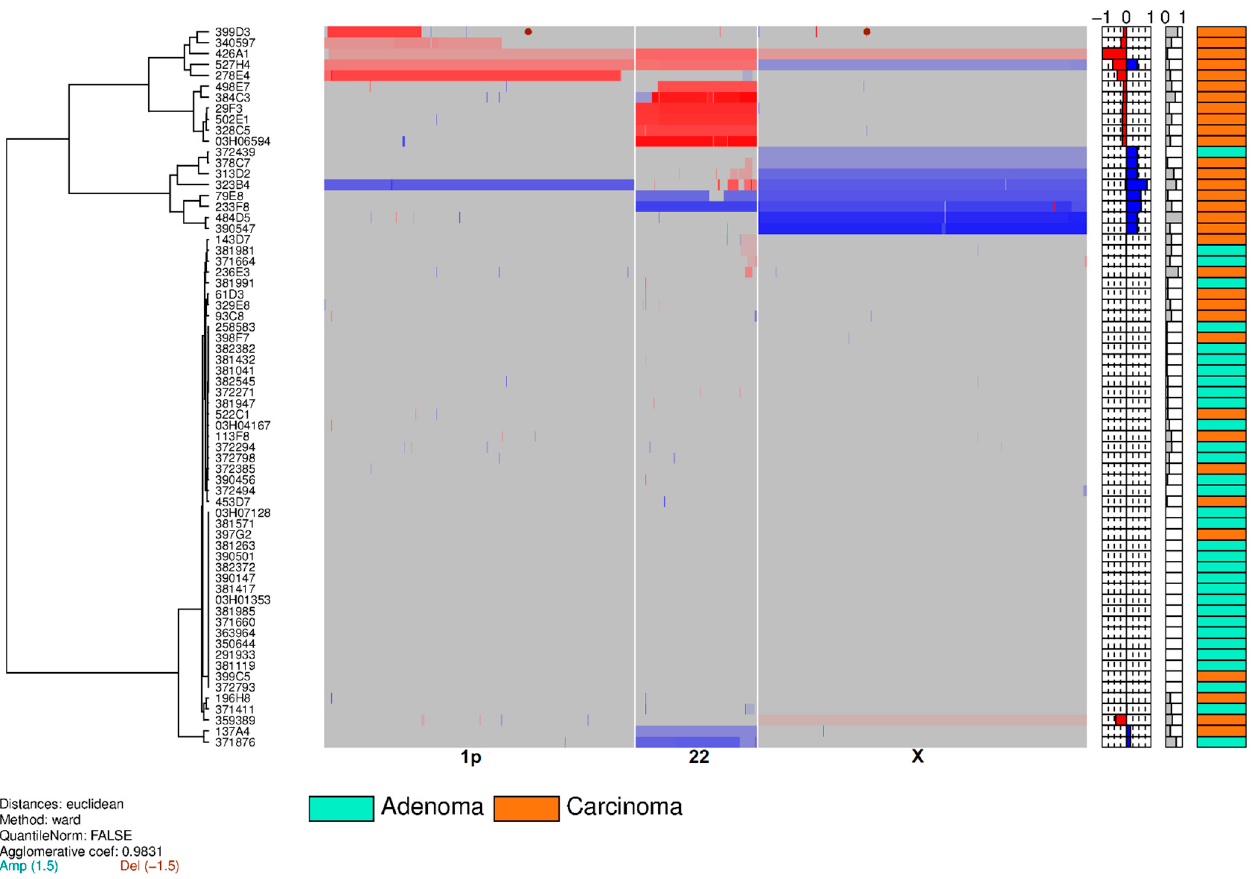
Figure 3. Heatmap of the three chromosomes / chromosome arms that can be used to distinguish between cFA and cFTC tissues in the training set of 66 samples: chromosomes 1p, 22 and X (Euclidean distance, Ward’s method). Abbreviations: Adenoma: classic follicular adenoma (cFA); Carcinoma: classic follicular thyroid carcinoma (cFTC).